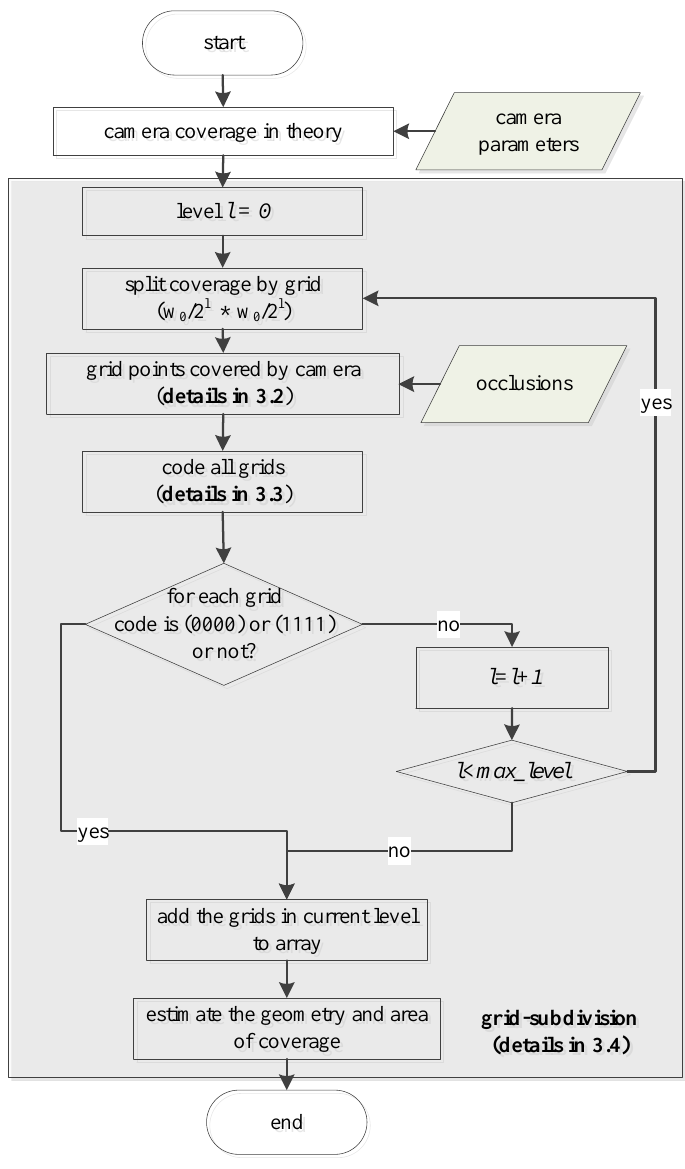
Figure 1. Flowchart of the proposed method.